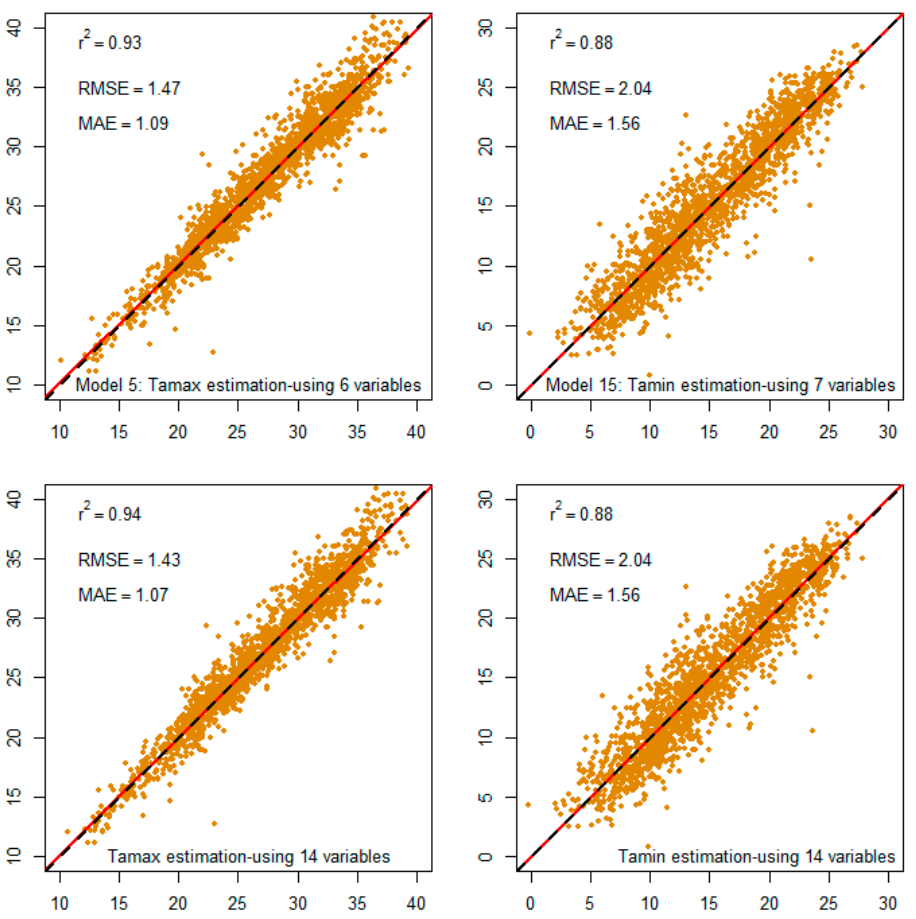
Figure 6. The comparison of estimated T a using Model 5, Model 15 and the model using 14 variables. The dashed black line indicates the 1:1 line. The solid red line shows the regression line.